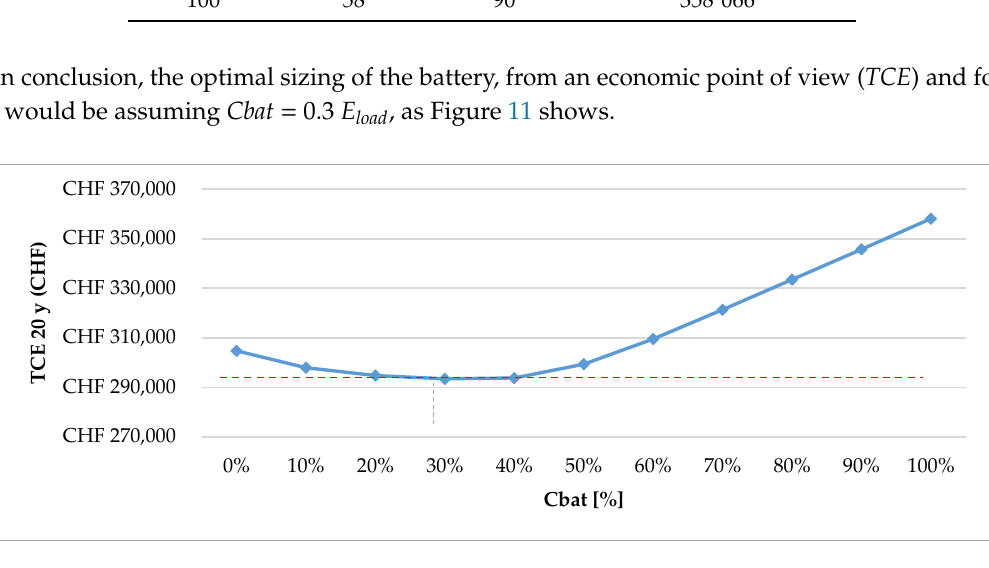
Figure 11. Comparison of the various storage capacity and the TCE in 20 years for MC1.